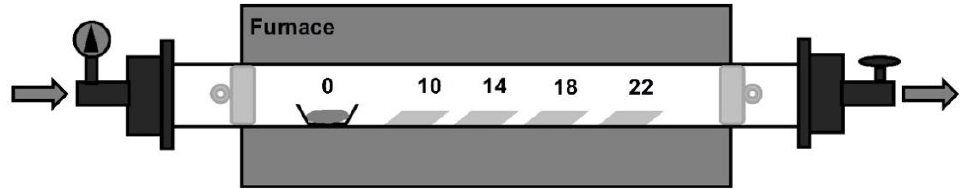
Figure 1. Scheme of the CVD system. Two quartz plugs were placed inside the quartz tube to establish the reaction zone. At the gas entrance (from left to right), was placed a quartz plug, at 10 cm from it was placed the boat with the precursor. The FTO substrates were located 10, 14, 18, and 22 cm from the boat. In the gas exit, a second plug was located (12 cm away from the last substrate). It is important to notice that the plugs do not seal the tube, they only obstruct the flow out from the reaction zone.